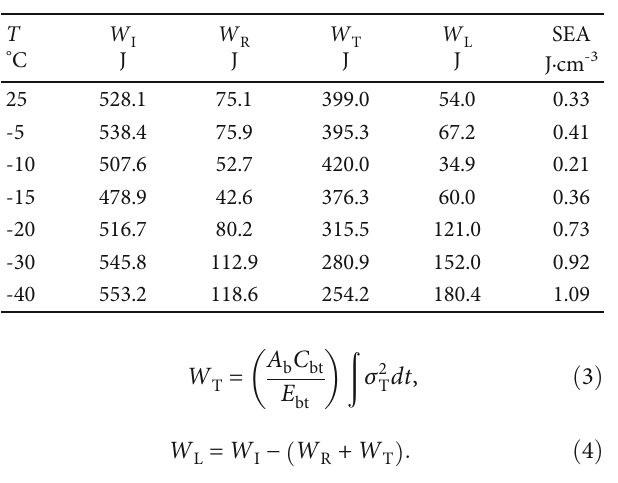
Table 2: Average energy statistics with various temperatures in the SHPB system for granite.